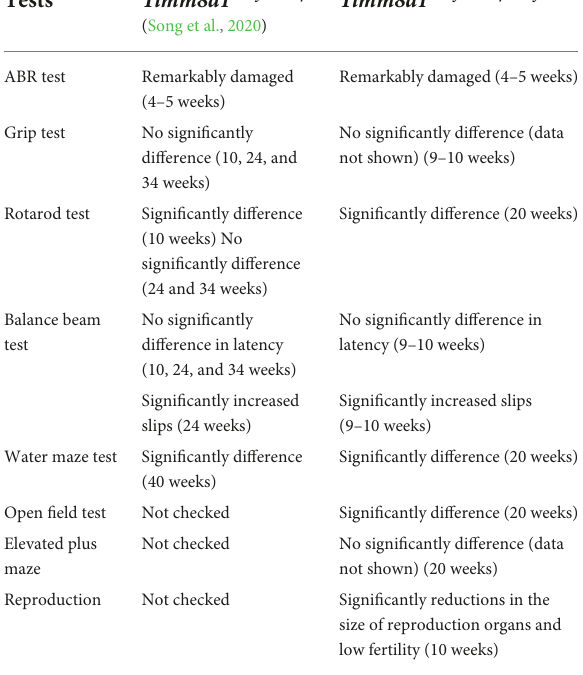
TABLE 1 Comparison of phenotypes between two genders of the Tim8a1 MUT